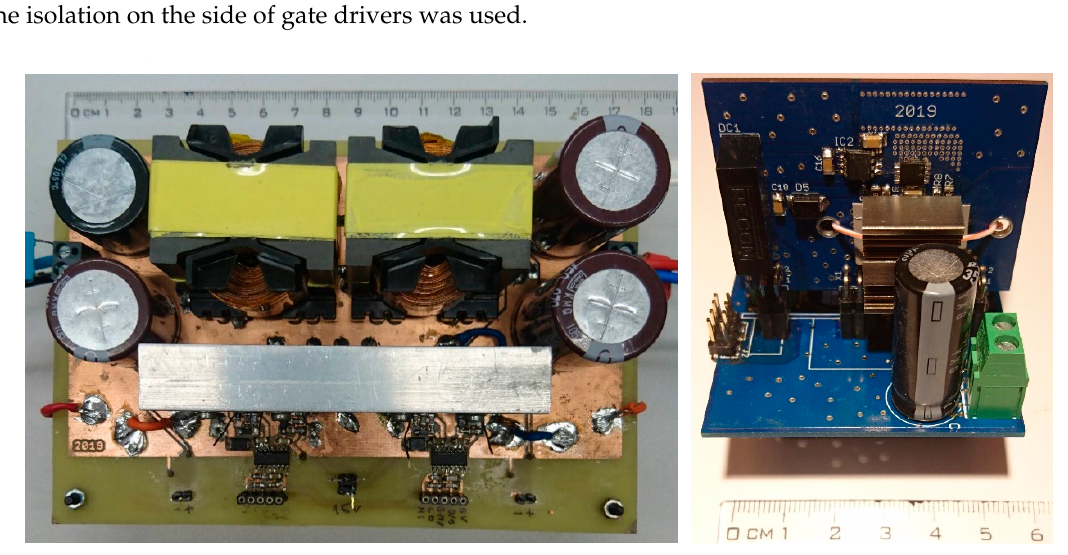
Table 5. List of used electronic parts for modular and non-modular concept.